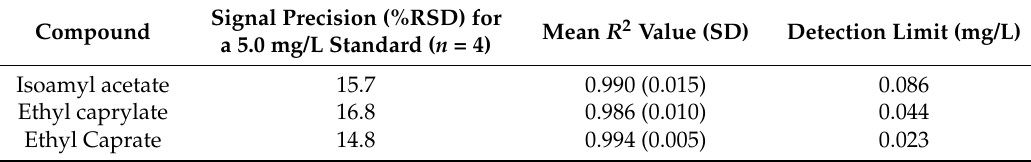
Table 7. Figures of merit for esters measured by headspace SPME GC.